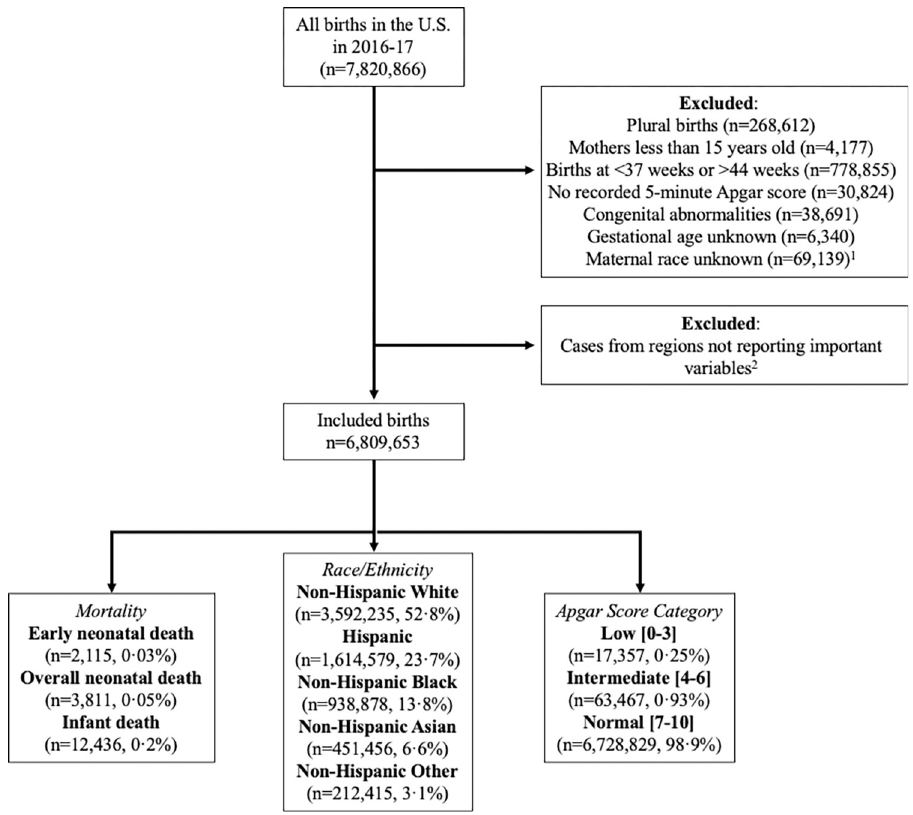
Fig 1. Flowchart of exclusions from study population to analysis cohort. 1 Exclusion criteria overlapped, these values represent the frequency of cases in the study population, not necessarily the frequency of excluded cases. 2 Important variables included maternal race, maternal education, number of prenatal care visits, smoking status, and 5-minute Apgar score.